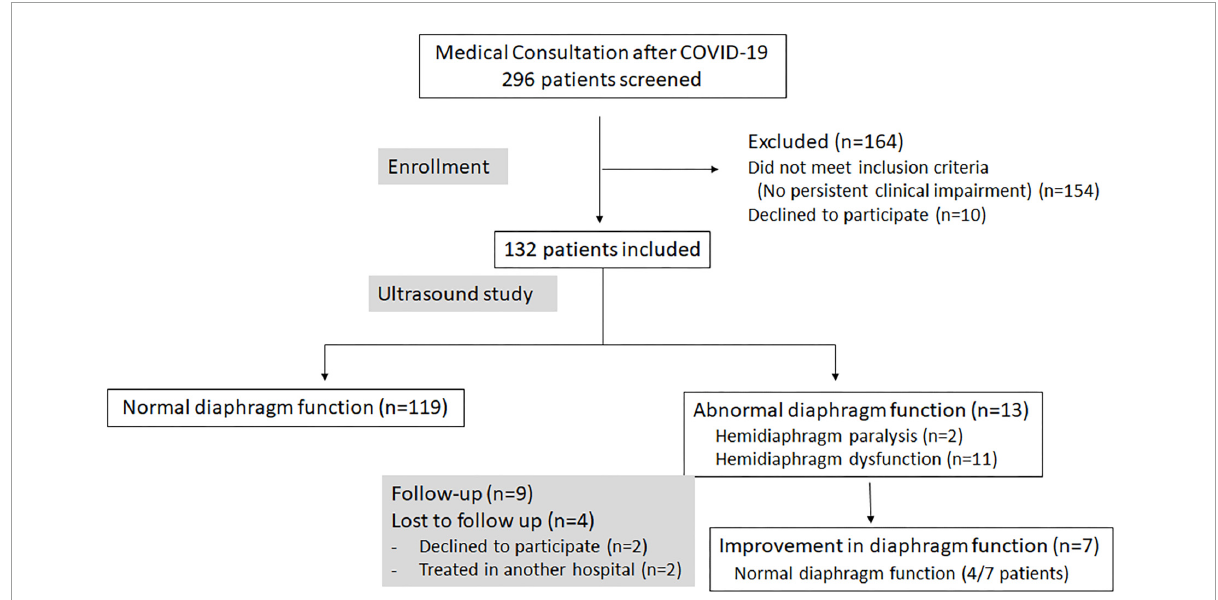
FIGURE1 Flow diagram showing the enrollment, the results of ultrasound examinations, and the follow-up of patients participating in the study.